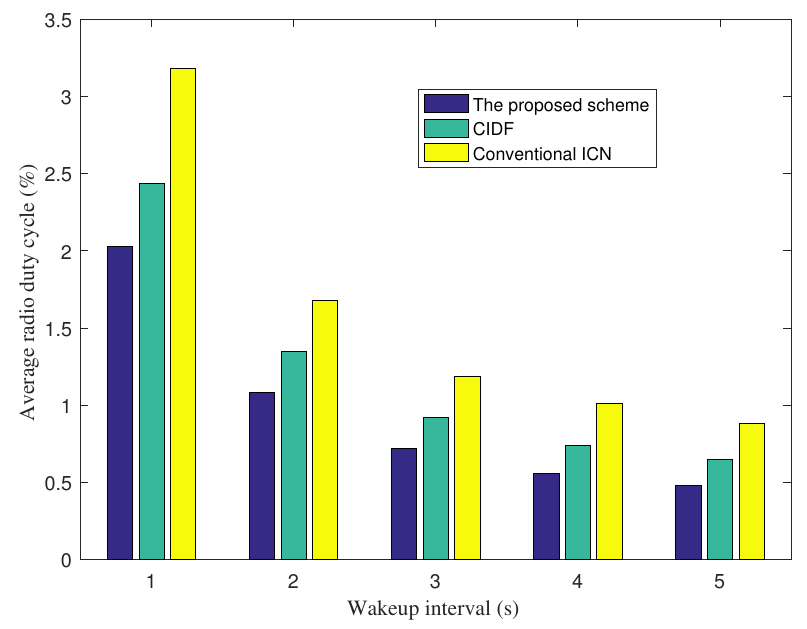
Figure 3. Average radio duty cycle vs. wakeup